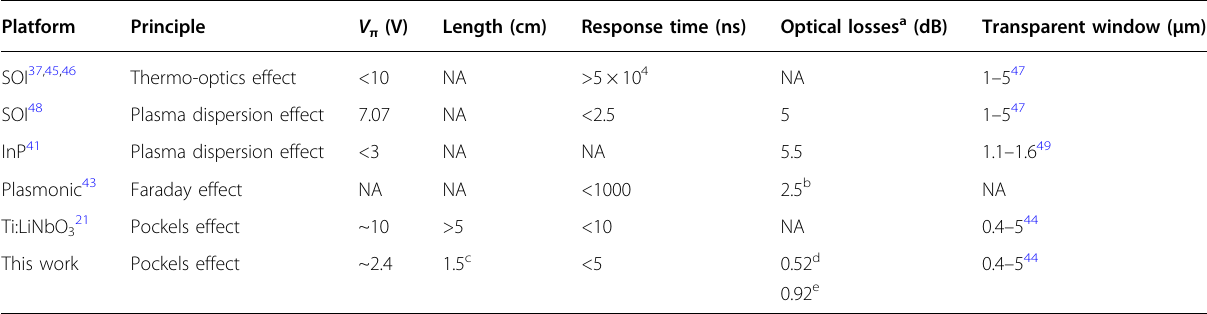
Table 1 The comparison of several performance metrics of the active integrated polarization management devices Platform